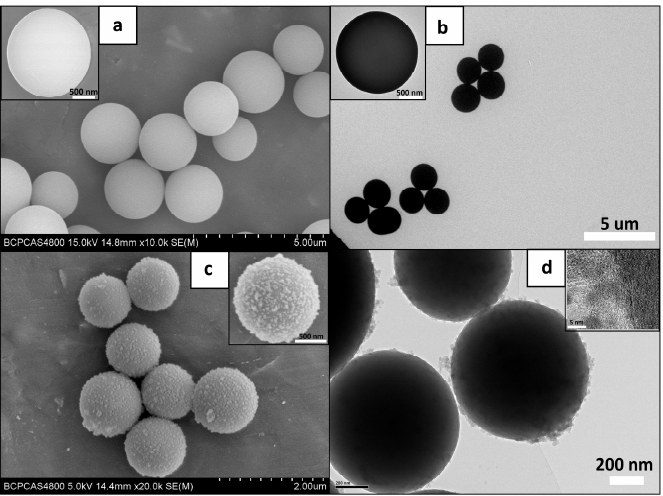
Figure 3. SEM and TEM images of PZS ( a , b ) and PZS@ZIF-67 ( c , d